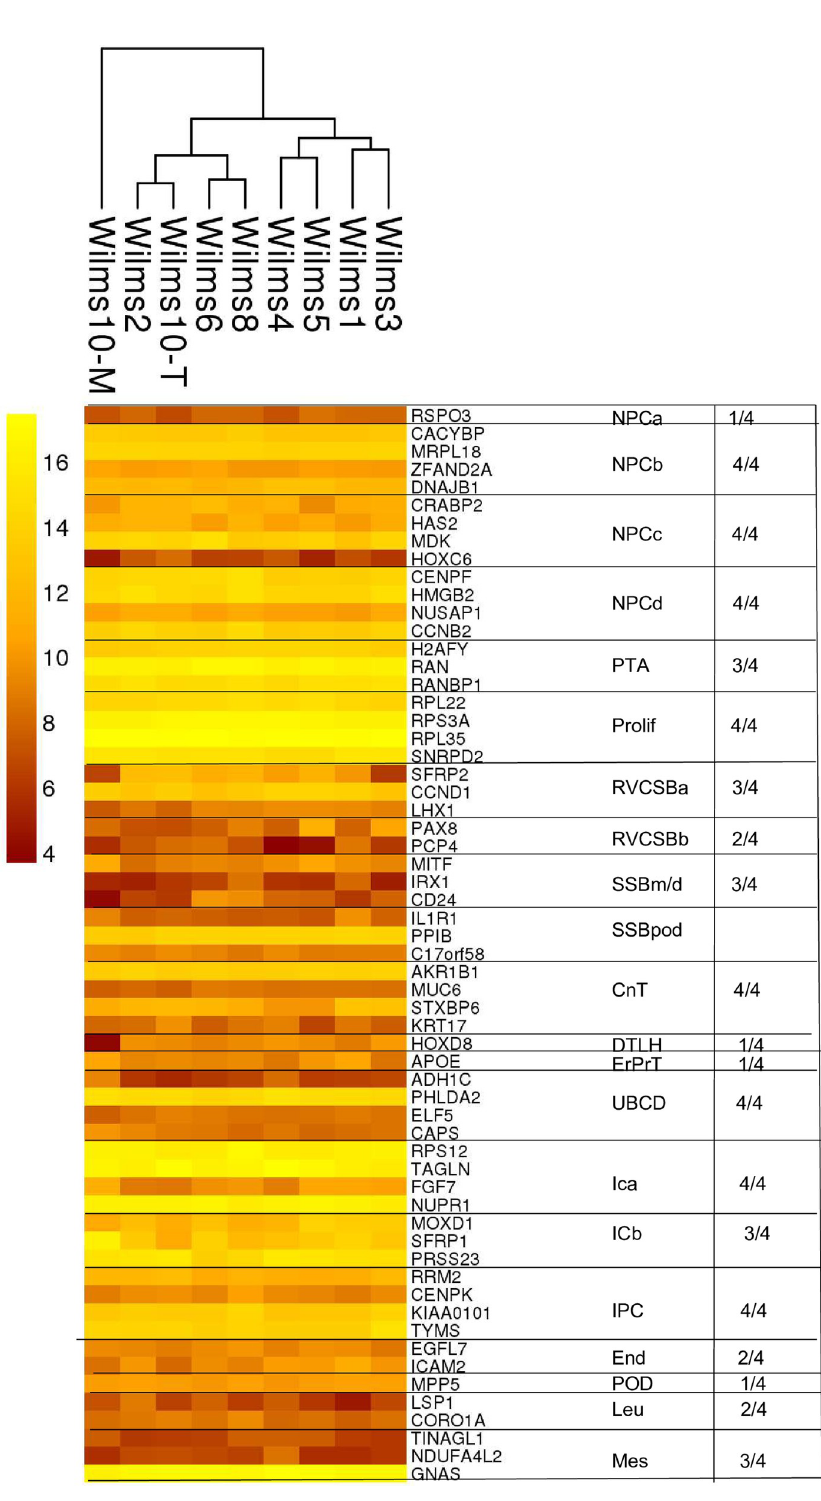
PLOS ONE | https://doi.org/10.1371/journal.pone.0270380 January 23,